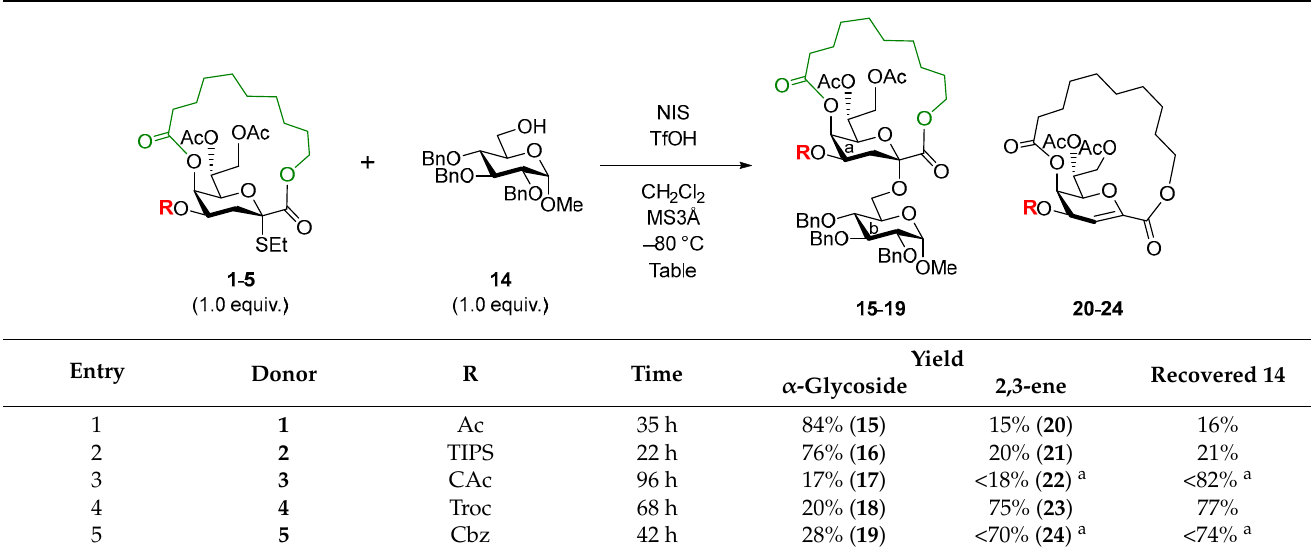
Table 1. α − glycosylation parameters using macrobicyclic Kdo donors. Table 1. α− glycosylation parameters using macrobicyclic Kdo donors.